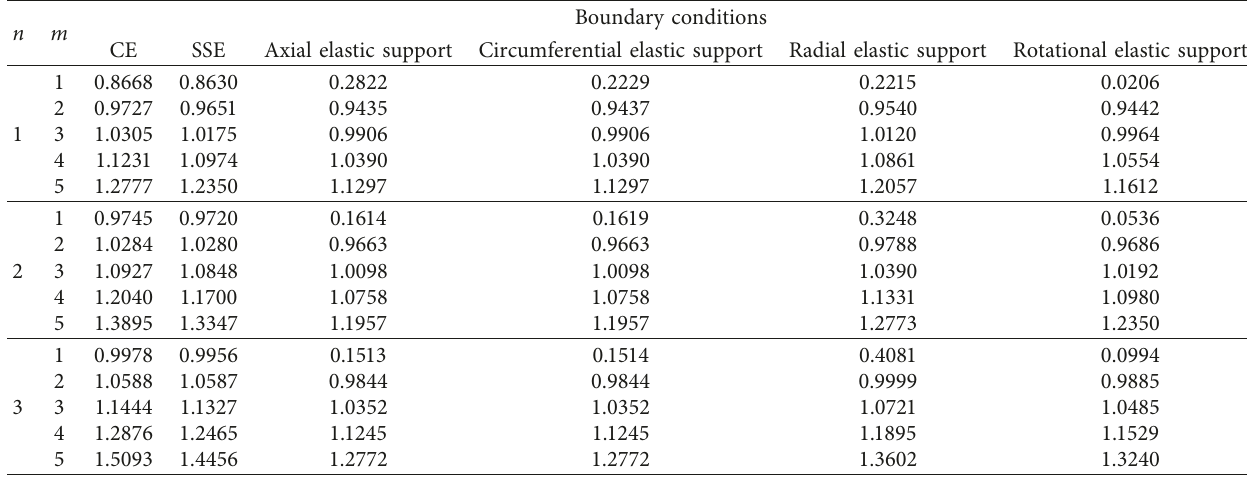
Table 7: Nondimensional frequency parameter of uniform 60 degrees spherical cap with different edge conditions.